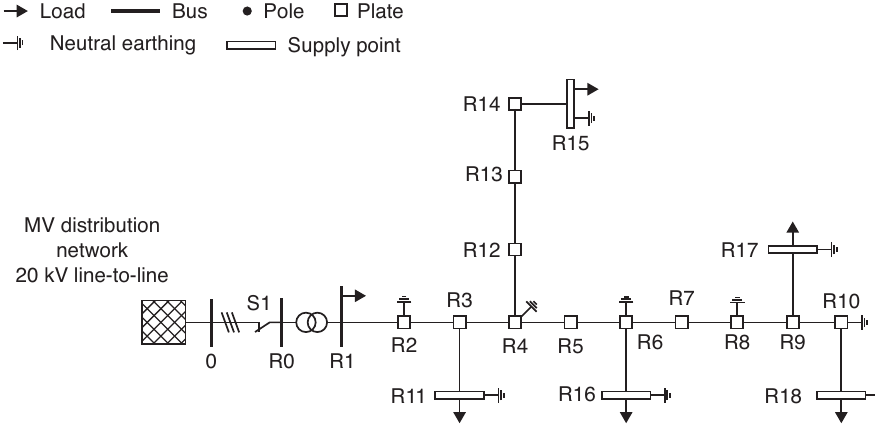
Figure 1. Modified CIGRÉEuropean Low Voltage Distribution Network Benchmark [23].